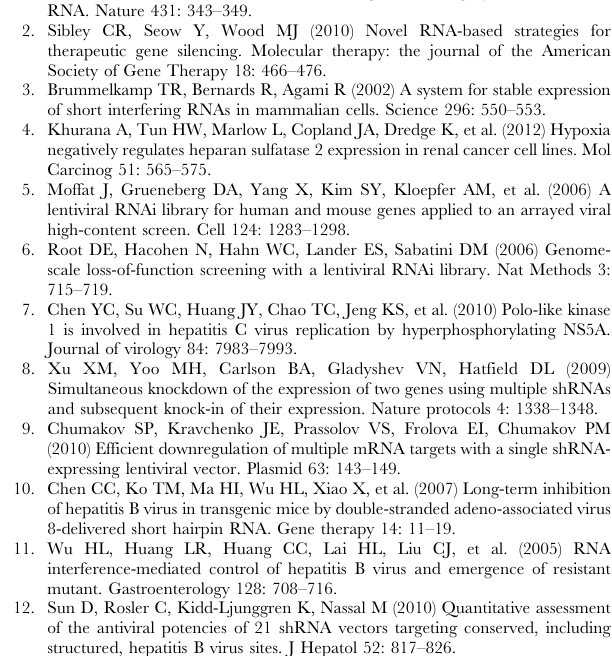
Figure S1 The effects of stem structures on shRNA silencing activity. The antisense-sense (AS) shRNAs and the sense-antisense (SA) shRNAs were compared with each other for their anti-HBV activity. The HBV target sequences ‘‘GGUAU- GUUGCCCGUUUGUCCU’’ (1856) and ‘‘CACUGUUUGG- CUUUCAGUUAU’’ (2116) were used in (A) and (B) respectively. (TIF) Figure S2 Transfection with shRNA vector AS139 inhib- ited HBV pc/pgRNA dose-dependently. Primers HBVF (CGTTTTTGCCTTCTGACTTCTTTC) and HBVR (ATAA- GATAGGGGCATTTGGTGGTC) were used for HBV pc/ pgRNA amplification. Lane 1, pshOK-basic:pHBV1.31 =1:1; Figure S3 Transfection with shRNA vector AS139 inhib- ited HBeAg antigen dose-dependently. HepG2 cells were seeded in 24-well plates and cotransfected with 200 ng of pHBV1.31, 200 ng shRNA plasmid (AS139 plus neg) and 100 ng pSEAP2-Control per well. The HBsAg and HBeAg concentrations in cell supernatants were detected 48 h post transfection. Means and standard deviations were generated from